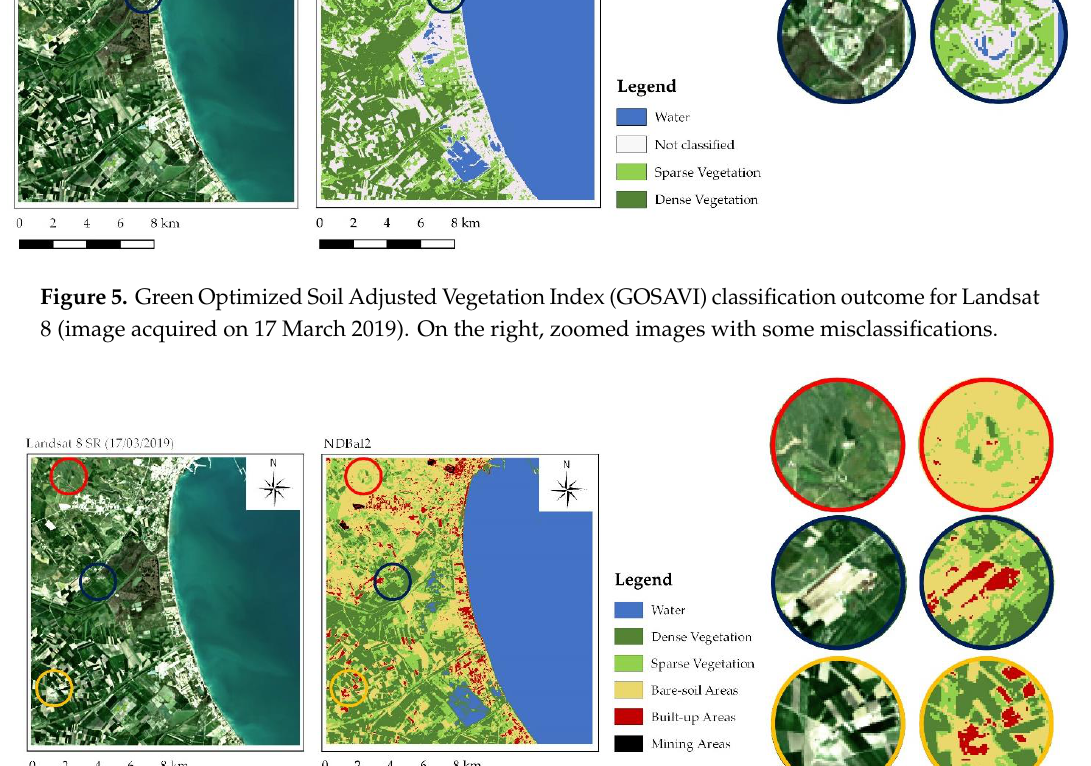
Figure 5. Green Optimized Soil Adjusted Vegetation Index (GOSAVI) classification outcome for Landsat 8 (image acquired on 17 March 2019). On the right, zoomed images with some misclassifications.